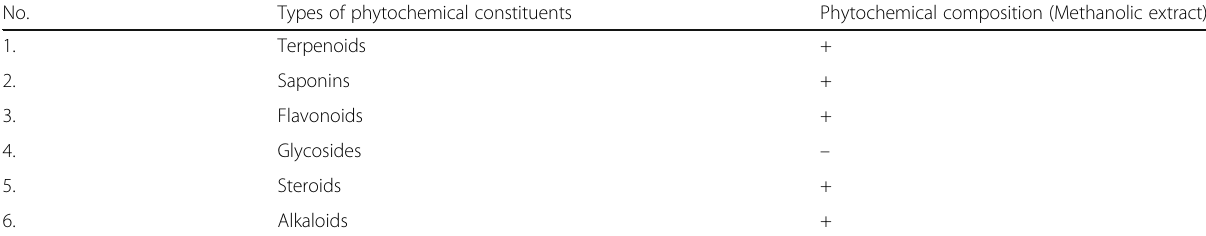
Table 1 Phytochemical screening of I. mauritiana